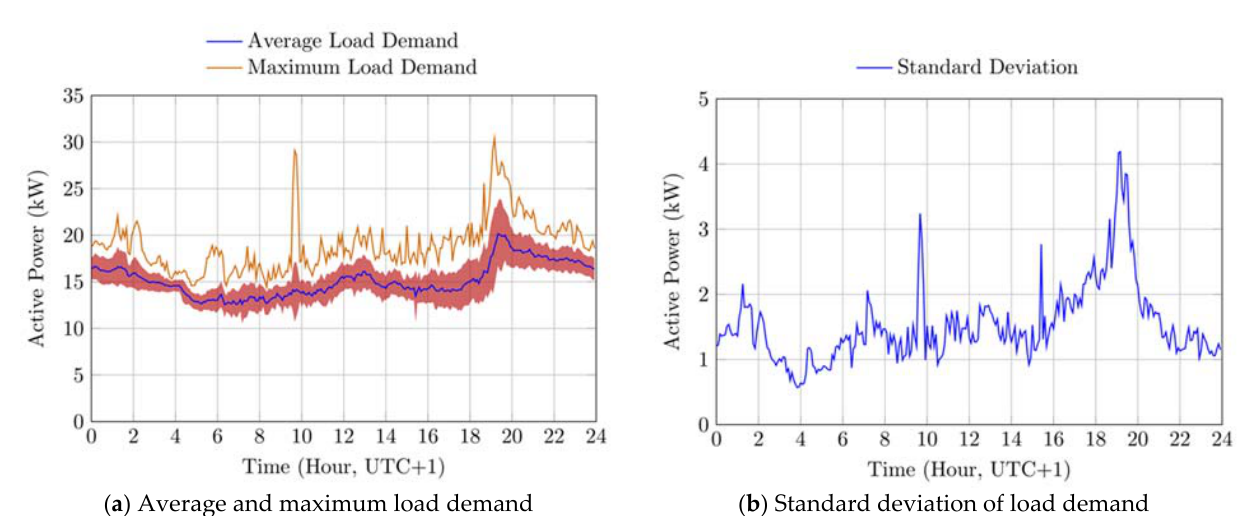
Figure 2. Active power demand profiles of loads during May 2020. In sub-figure ( a ), the red area represents the standard deviation of the measurements for each i -th time interval, which is reported in detail in sub-figure ( b ). UTC: universal time coordinated.